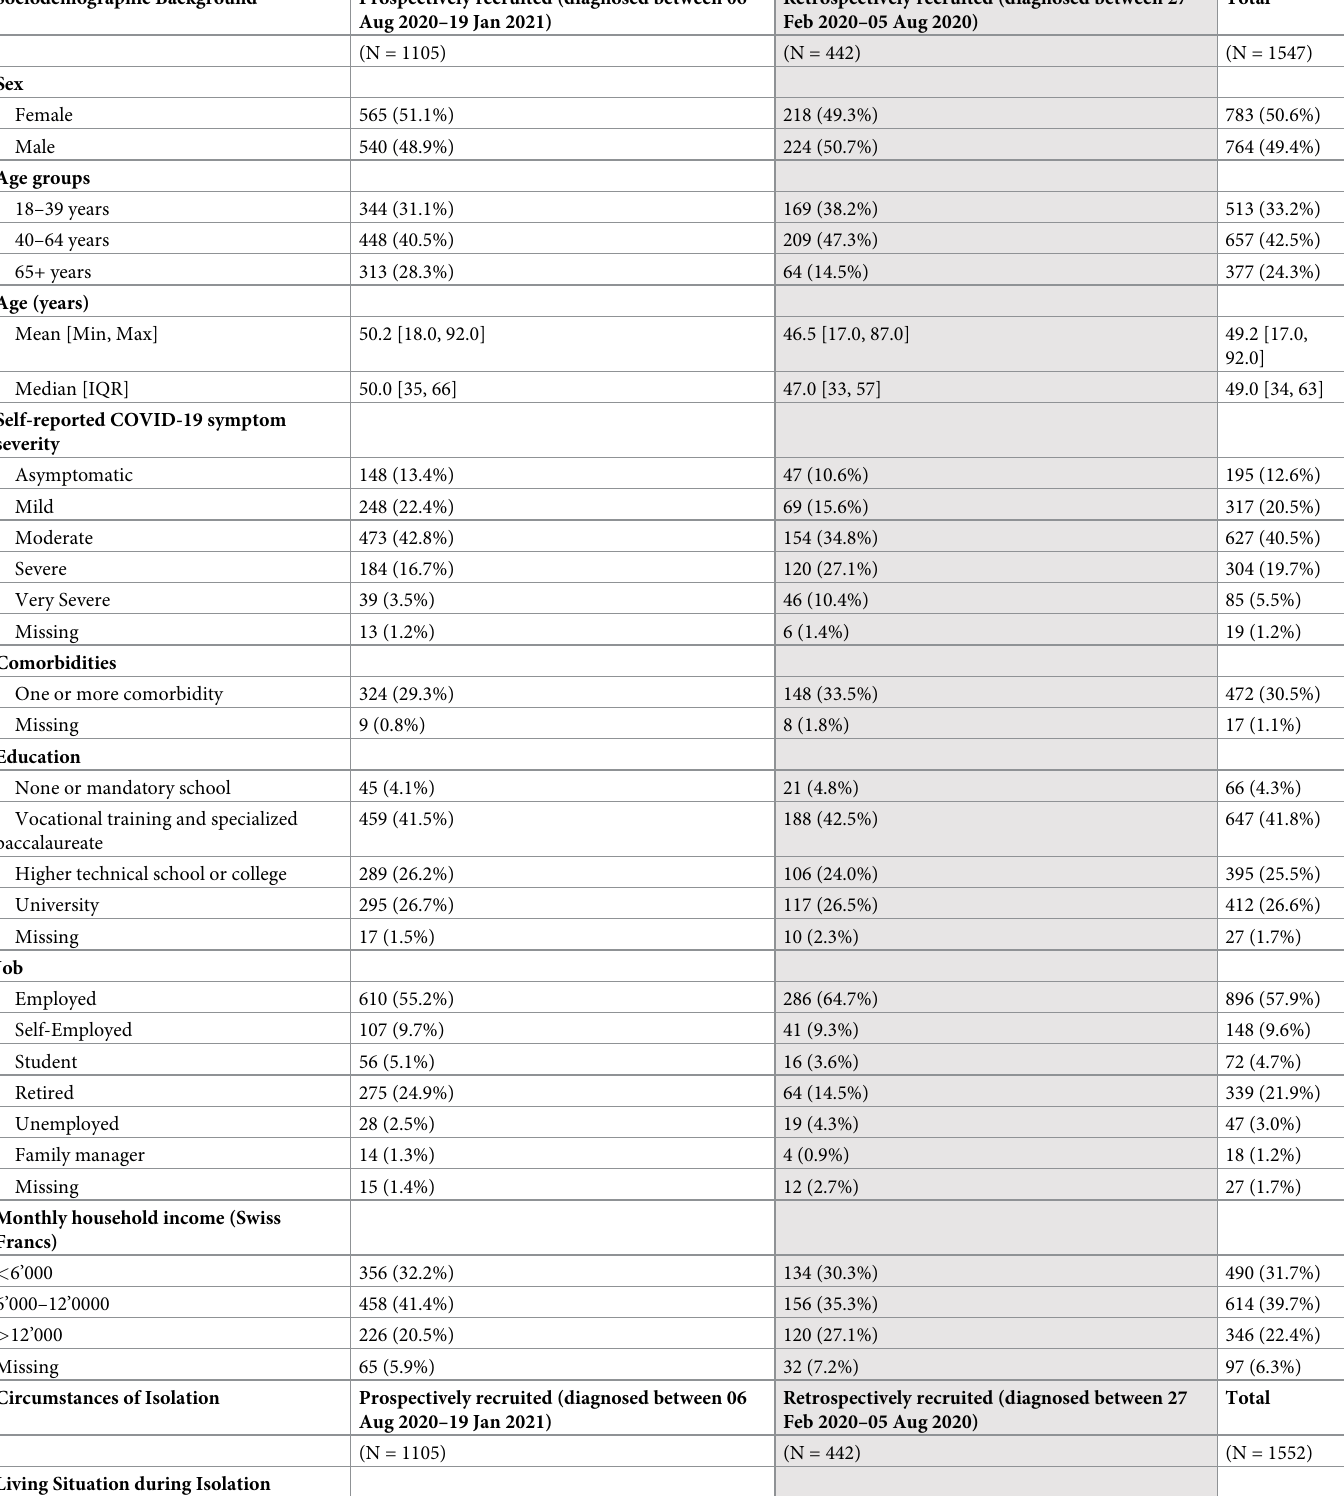
Table 1. Characteristics of participants enrolled in the Zurich SARS-CoV-2 cohort study. Sociodemographic